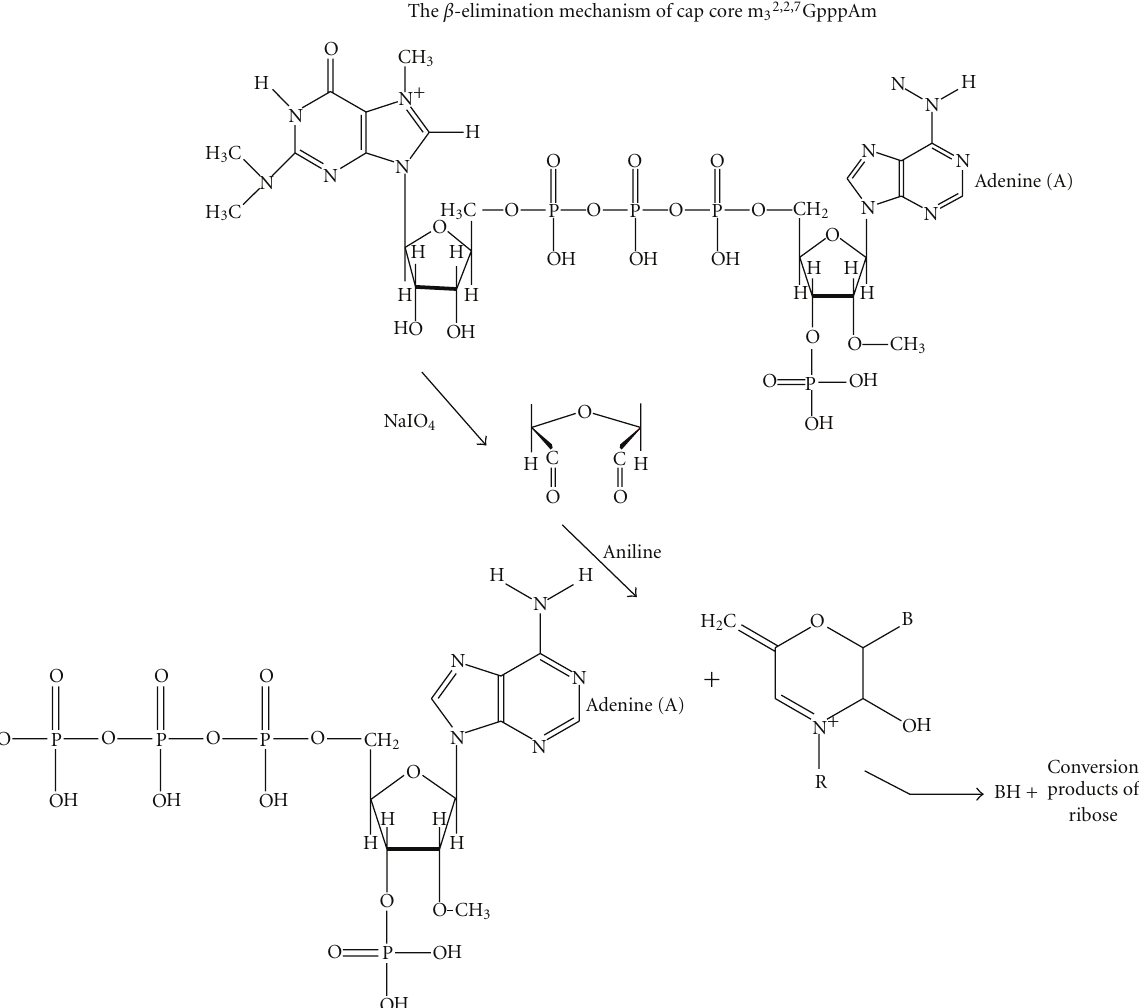
Figure 24: The β -elimination of cap core [16]. The cap core (peak b from Figure 23) was treated with NaIO 4 and aniline to remove m 32,2,7 G by β -elimination reaction. The remaining nucleotide was chromatographed in the ATP region indicating it is pppAm. This proved that the cap core was m 32,2,7